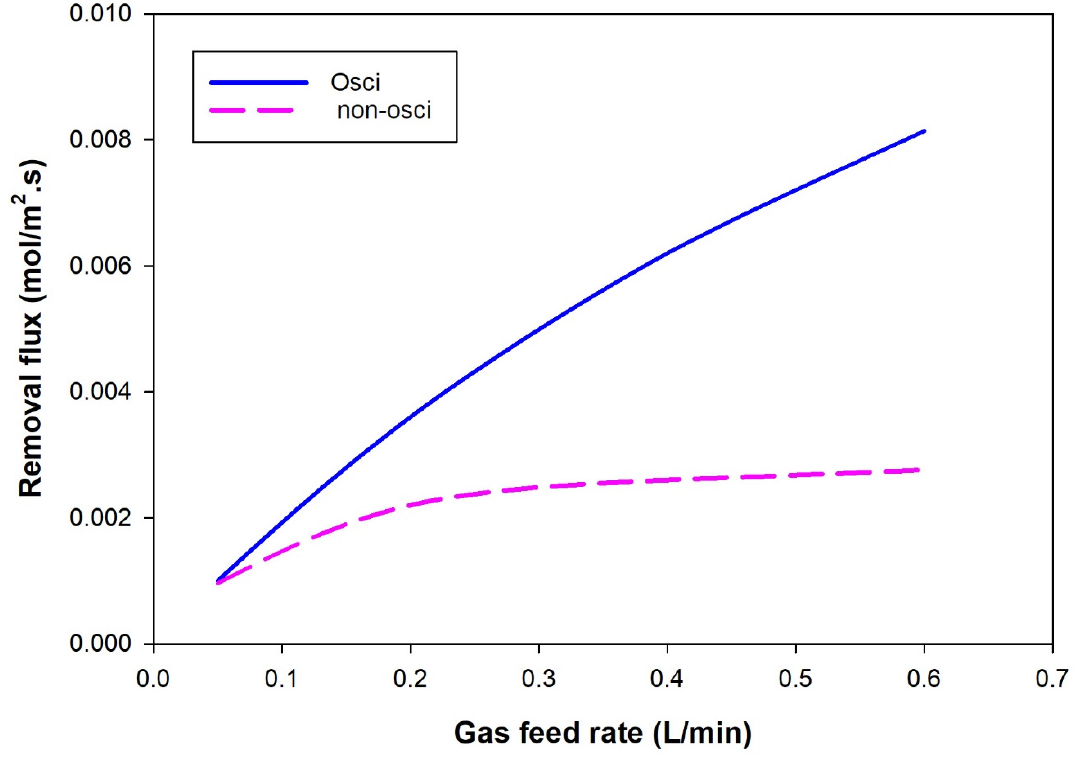
Figure 8. Influence of feed perturbation on the CO 2 removal flux under the effect of oscillatory and non-oscillatory gas feed rate. The oscillating mode was at the optimum frequency of 0.05 HZ.